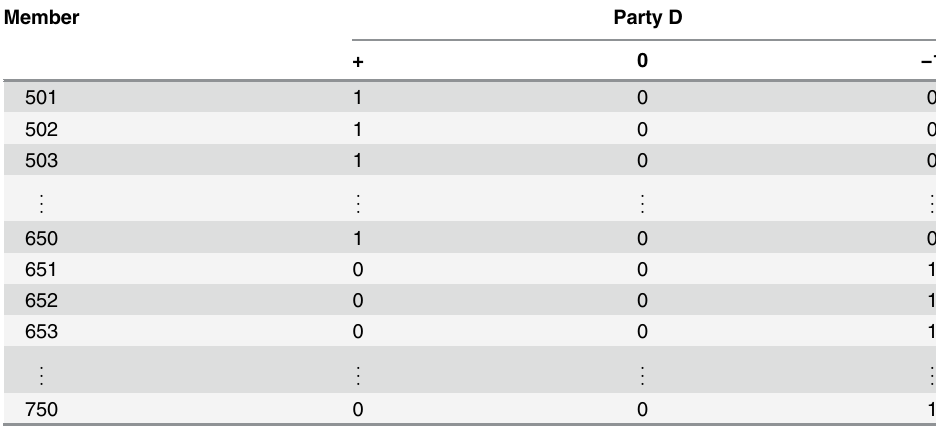
Table 6. A decomposition of Table 2 into multi-tables of Boolean-valued for Party D.